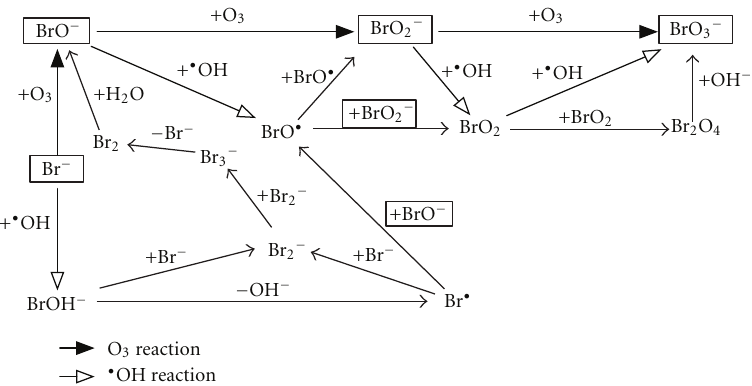
Figure 3: BrO 3 − formation pathways illustrated on the basis of Von Gunten and Oliveras